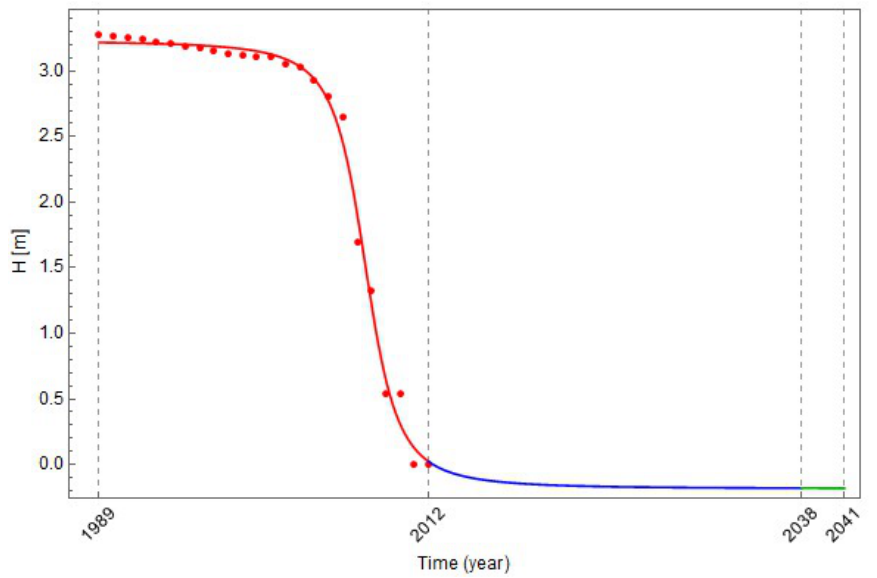
Figure 9. Graphical presentation of results from analysis of vertical displacement of point GB/6; best fit theoretical modified sigmoid function till last measurement in 2012 (red curve), predicted function between years 2012 and 2038 corresponding to active state of subsidence (blue curve) and consolidation period from 2038 till final observation measurement in 2041 (green curve).